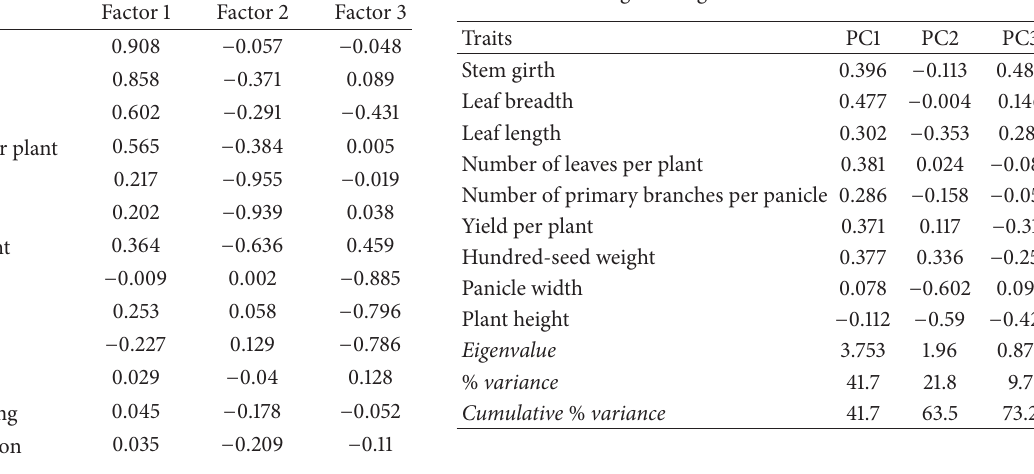
Table 4: Sorted rotated factor loadings of quantitative traits. Table 5: Principal components analysis showing the contribution of 9 characters among the sorghum